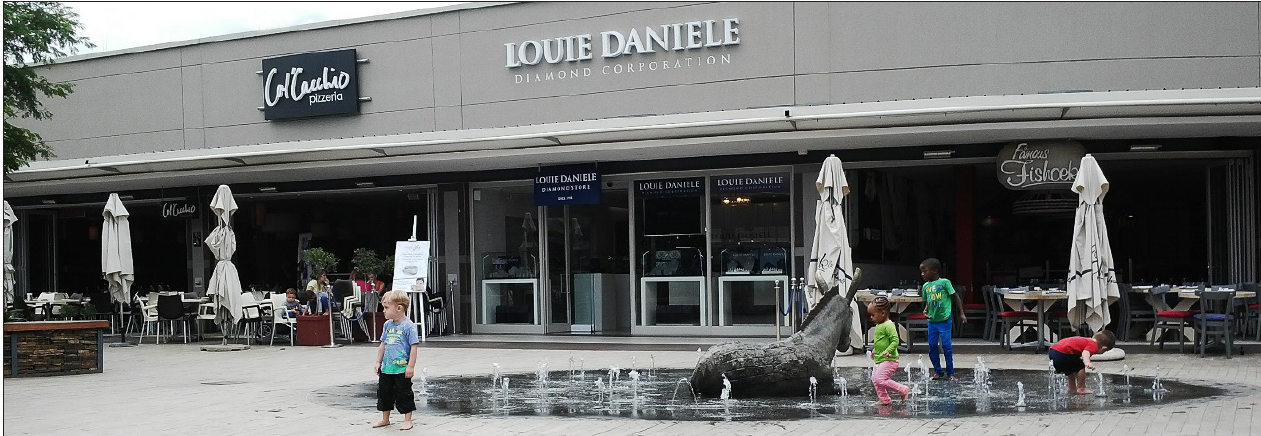
Figure 10: A prominent sculpture with fountain that is often used by children as a play space in the Lynnwood Bridge plaza Source: Author